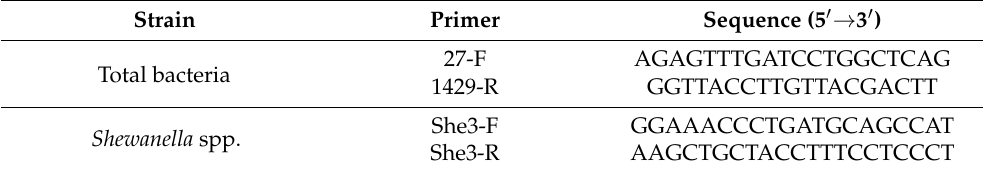
Table 2. The specific primer sequence of the